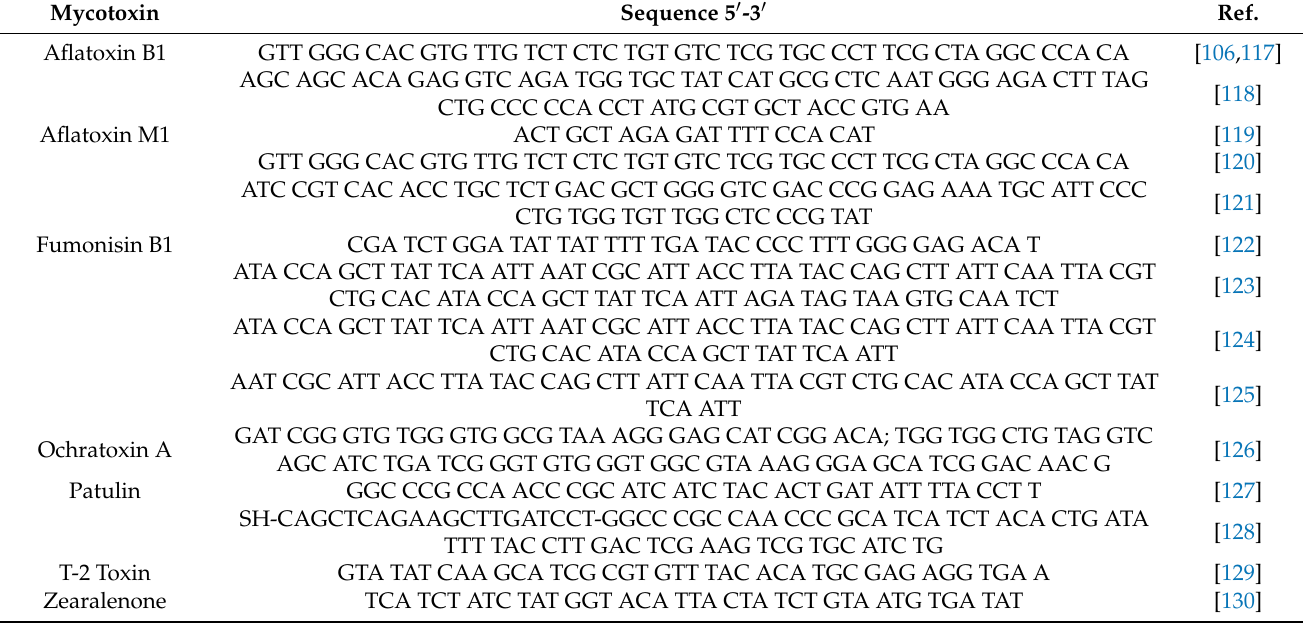
Table 3. The structure of the DNA aptamers selective toward mycotoxins (see also Section 3). Mycotoxin Sequence 5 (cid:48) -3 (cid:48)